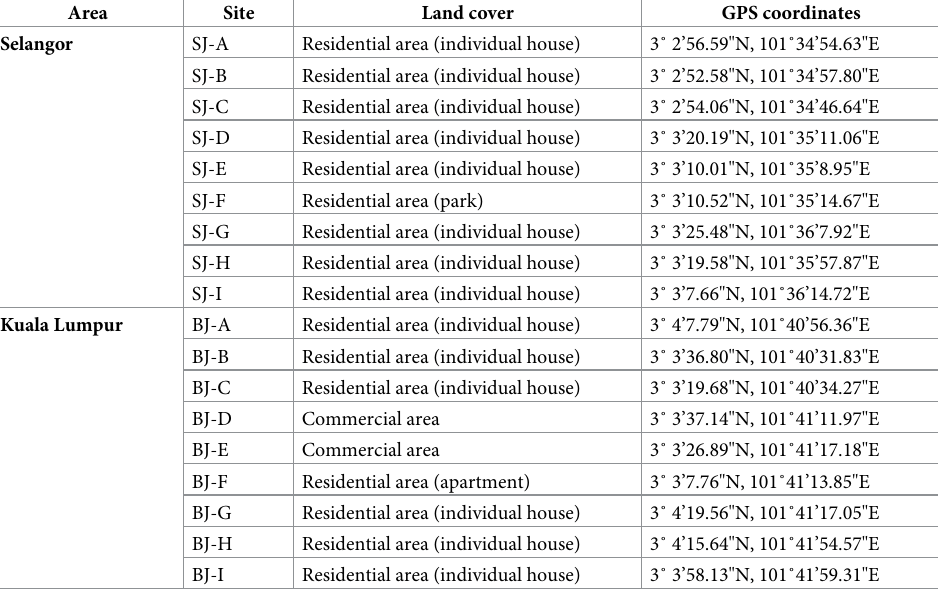
Table 1. Land cover and GPS coordinates of sampling sites within Selangor and Kuala